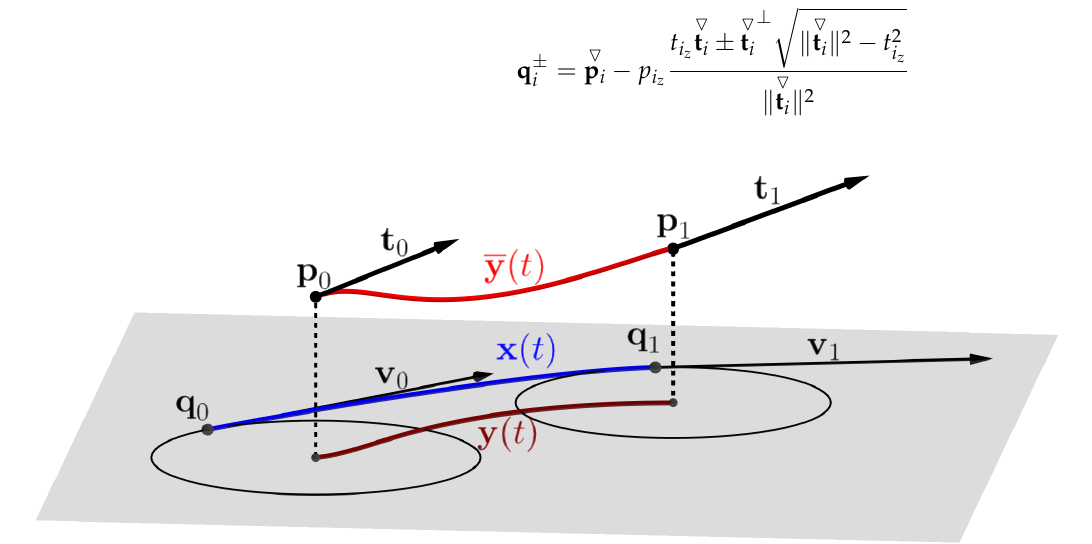
Figure 1. Constructing the RE curve y ( t ) for input data p 0 , p 1 , t 0 , and t 1 , using the method of Bizzarri et al.